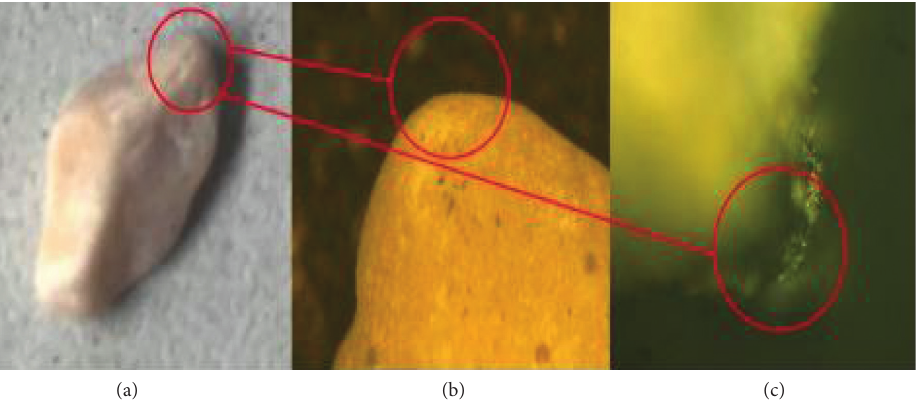
Figure 3: Microstructures of round rocks.